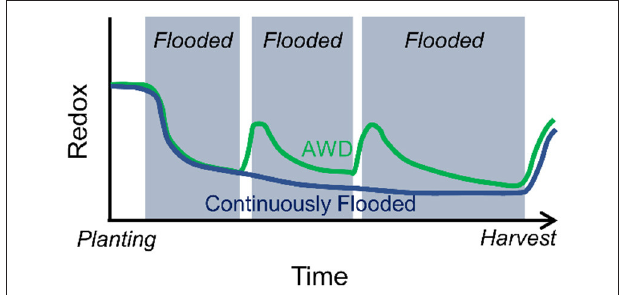
FIGURE 1 | The effect of water management on soil and pore water reduction-oxidation conditions (soil “redox”). Under continuously flooded conditions, sufficient labile carbon and limited oxygen influx result in low redox values throughout the growing season. Under AWD, the field is occasionally dried between flooded periods (shaded), raising the redox value. The timing, duration, and intensity of dry downs in AWD can be optimized to field specific